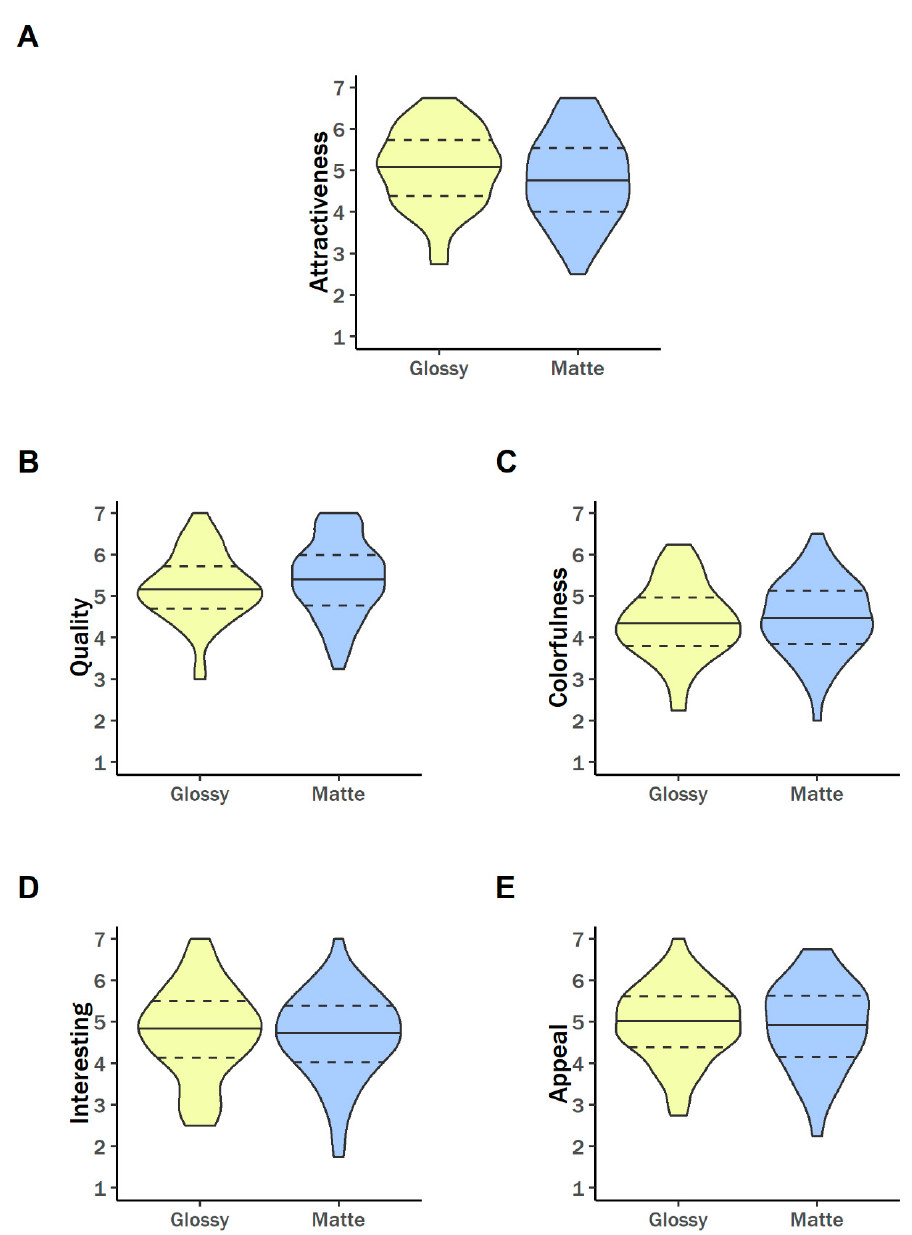
Figure 1. Effects of glossy versus matte paper on the outcome variables, which were ratings for the images’ ( A ) attractiveness, ( B ) quality, ( C ) colorfulness, ( D ) interestingness, and ( E )